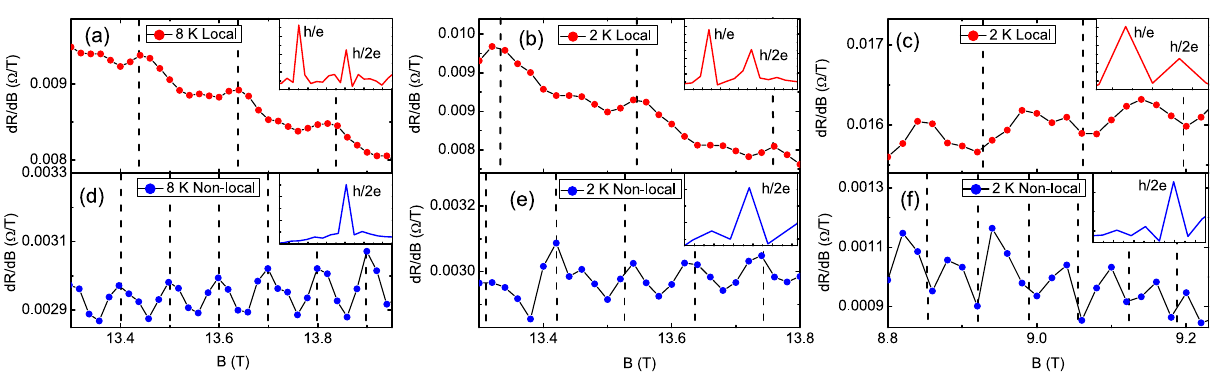
Figure 3. The magnetoresistance as a function of magnetic fields. ( a – c ) The dR / dB in local configuration, and ( d – f ) the dR / dB in nonlocal configuration. The oscillation period in the local configuration is double of that in the nonlocal